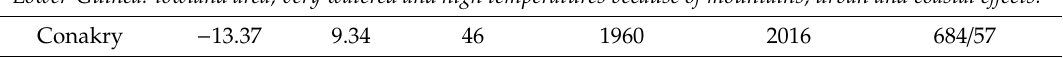
Available Data (monthly / year)